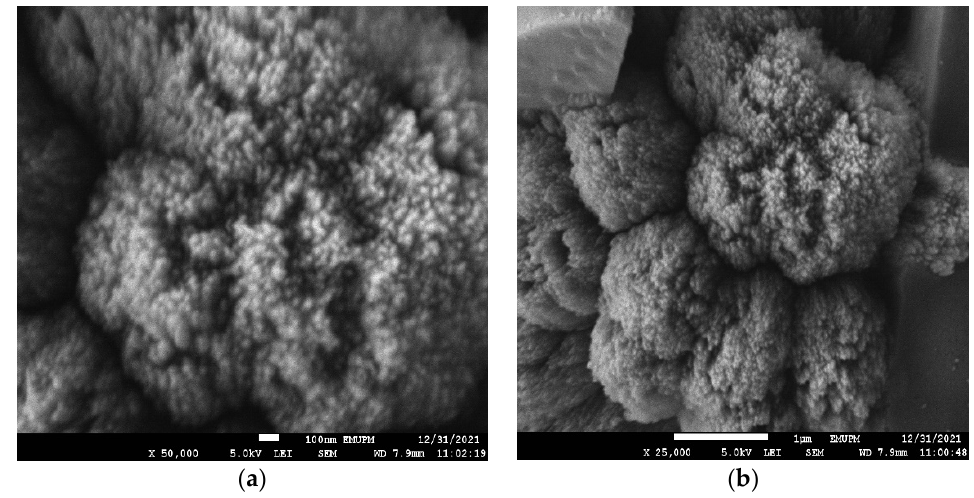
Figure 10. FESEM image of ( a ) and ( b ) dextran-coated nCPs (2g DEX) at different magnifications.